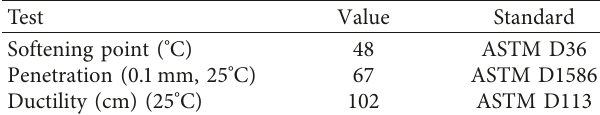
Table 1: Basic properties of asphalt binder.